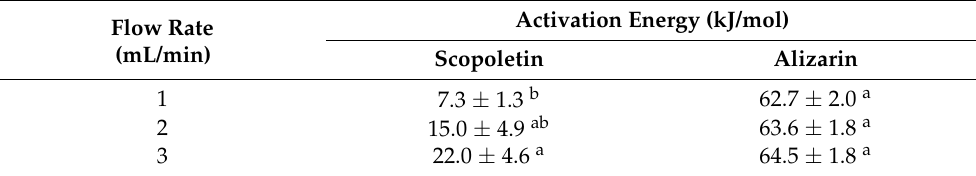
Table 4. Activation energies of scopoletin and alizarin during subcritical water